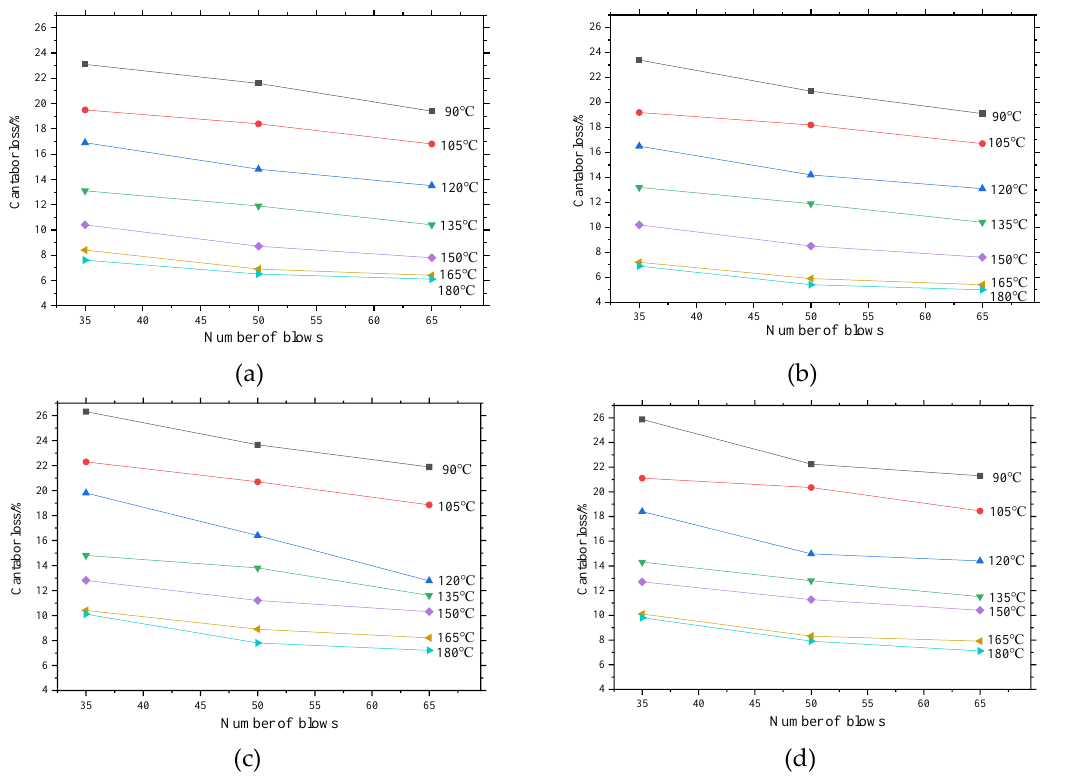
Figure 5. E ff ects of number of blows on Marshall sample Cantabro loss: ( a ) PAC-1-I, ( b ) PAC-1-II, ( c ) PAC-2-I, ( d ) PAC-2-II.